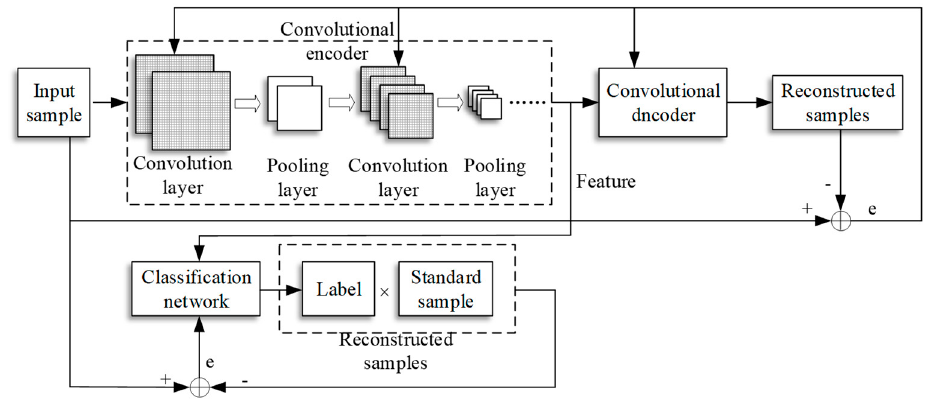
Figure 4. Self-supervised Voltage Sag Source Identification Method Based on CNN.